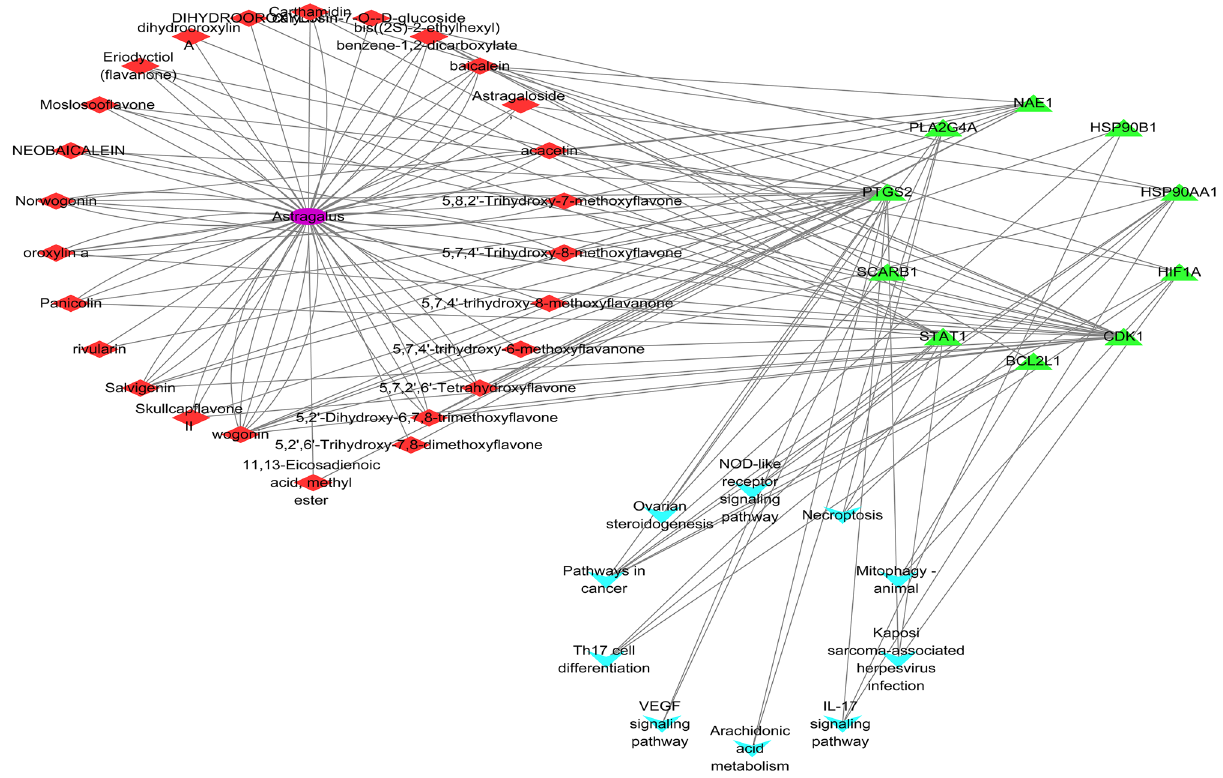
Figure 6. Construction of a drug-active ingredient-target-signalling pathway network. The purple module represents the drug, the red module represents the active ingredient, the green module represents the crossover genre and the blue module represents the KEGG